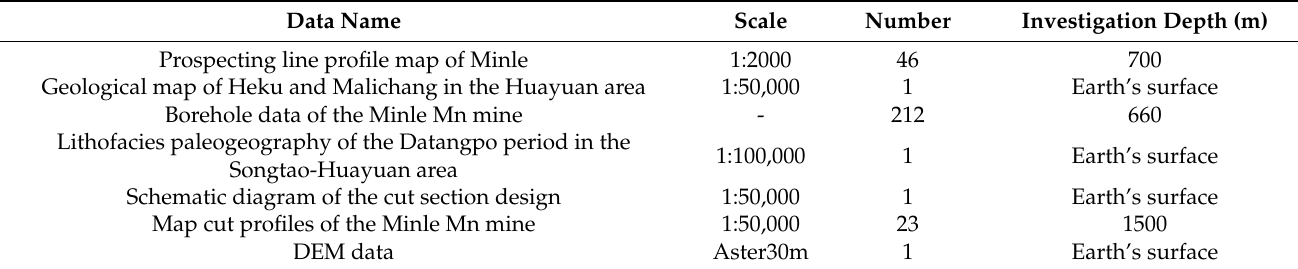
Table 3. The collected data in the Huayuan 3D deep learning